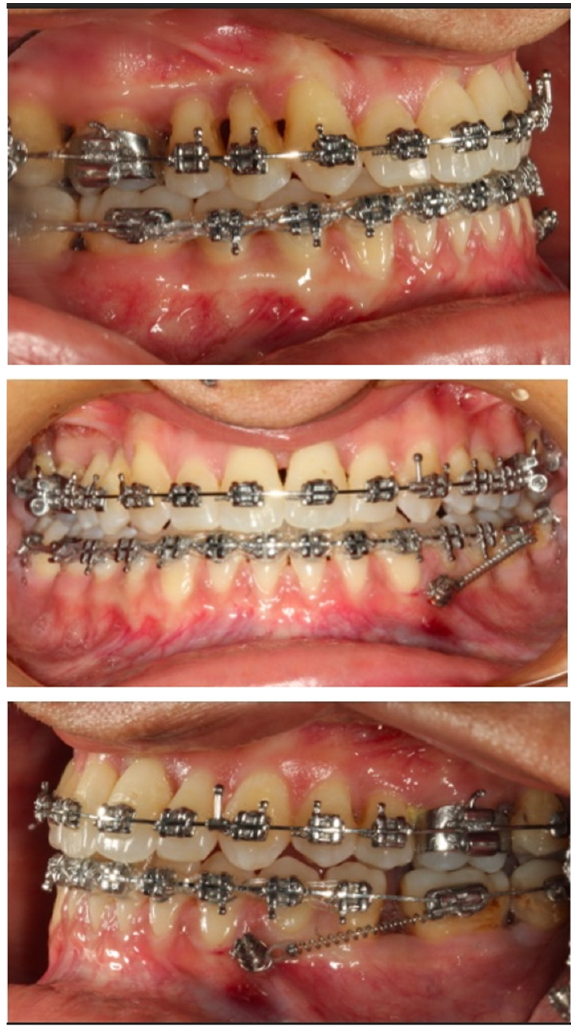
Figure 5. Correction of the midline deviation by mesializing the left posterior teeth using mini-screw